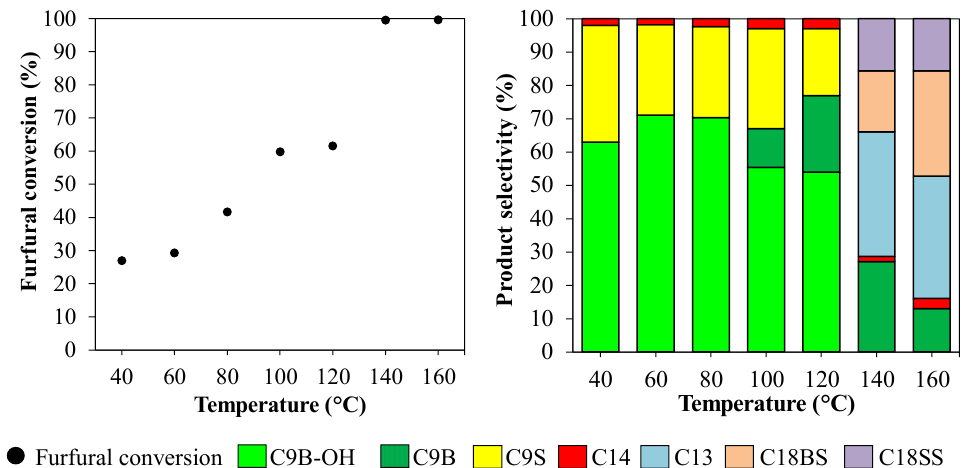
Figure 8. Effect of reaction temperature on furfural conversion and product selectivity obtained from aldol condensation of furfural and 2-butanone over LDO3 catalyst. (Reaction conditions: furfural:2-butanone molar ratio, 1:5; catalyst loading, 5 wt.%; time, 8 h; N 2 pressure, 10 bar).